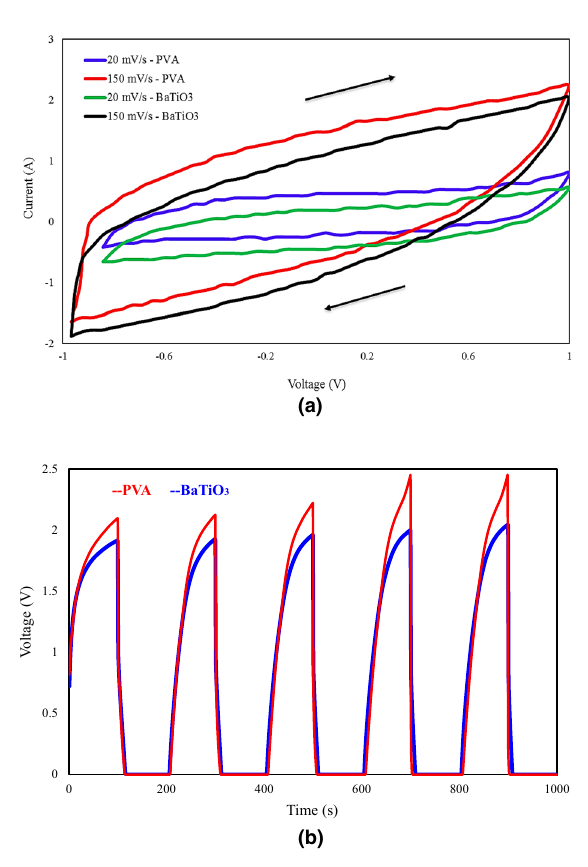
Fig. 8 a Cyclic voltammetry (CV) at 20 mV s −1 and 150 mV s −1 , b